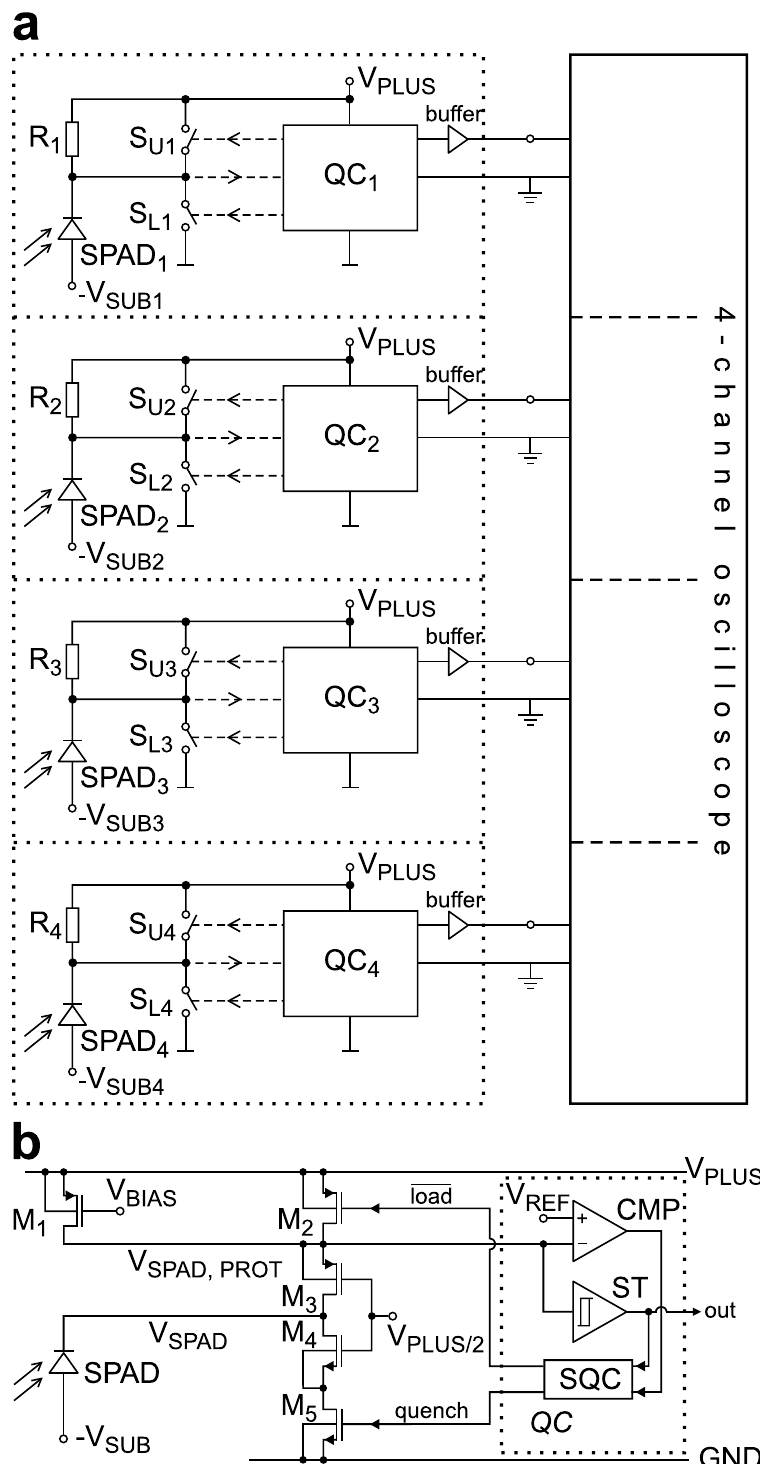
Figure 3. ( a ) Block diagram of 4-channel receiver connected to an oscilloscope, ( b ) quenching